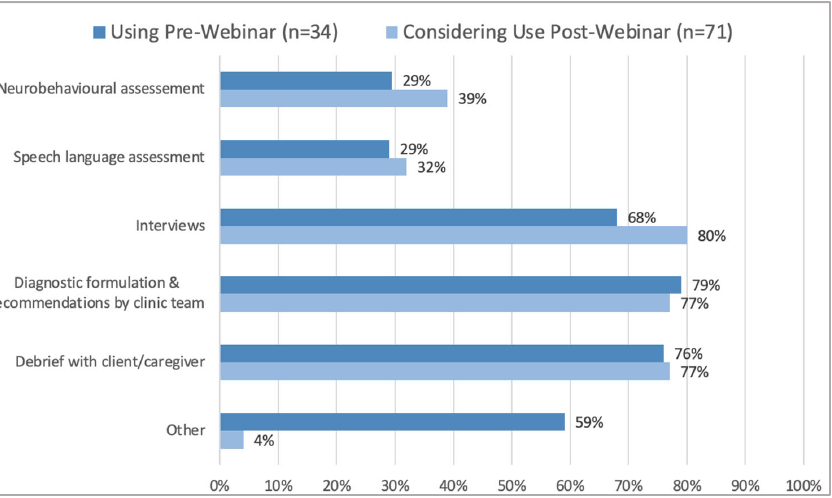
Figure 2. Parts of the assessment or diagnostic clinic process being used pre ‐ webinar and considered post ‐ webinar by FASD diagnostic teams.